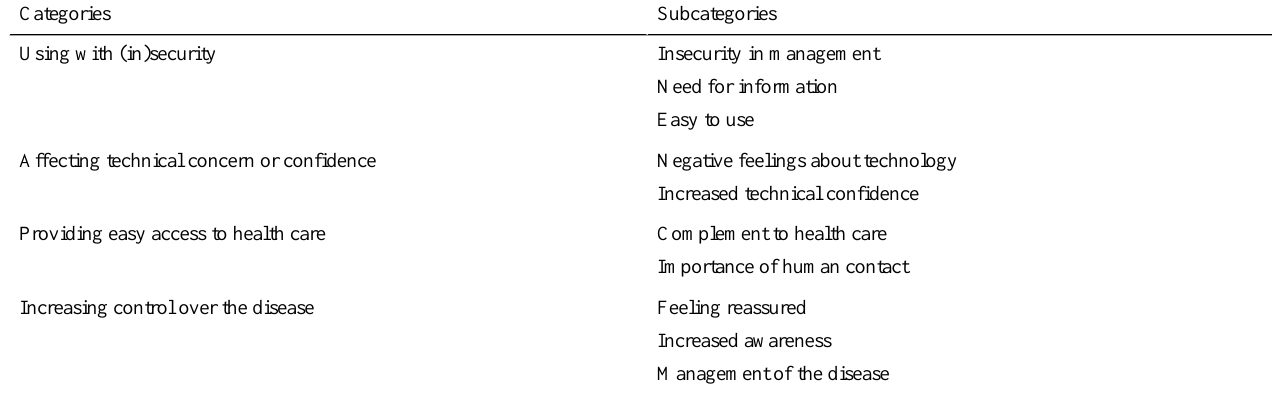
Table 2. Categories and subcategories of the theme A transition toward increased control and security.